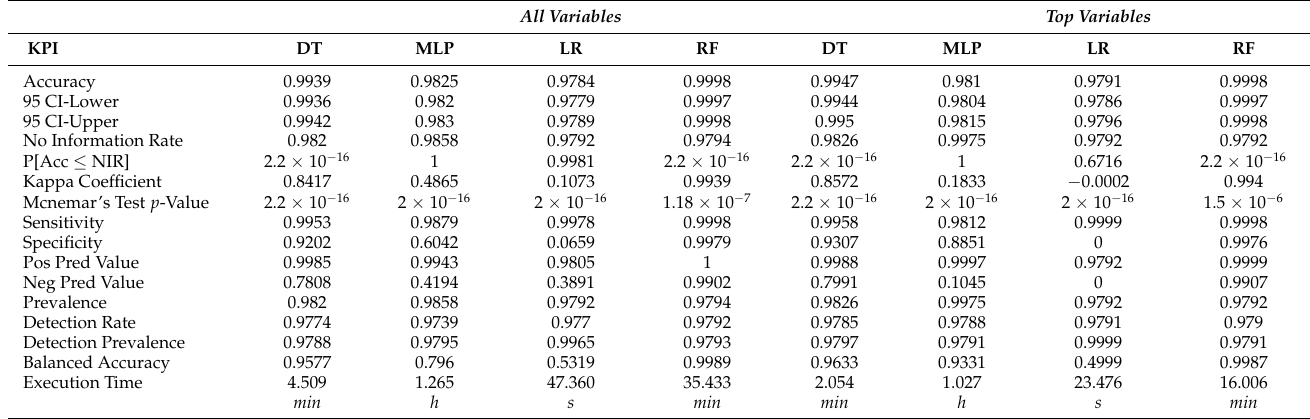
Table 8. Methods Comparison by Key Performance Indicators: Alarm Prediction in 24 h.